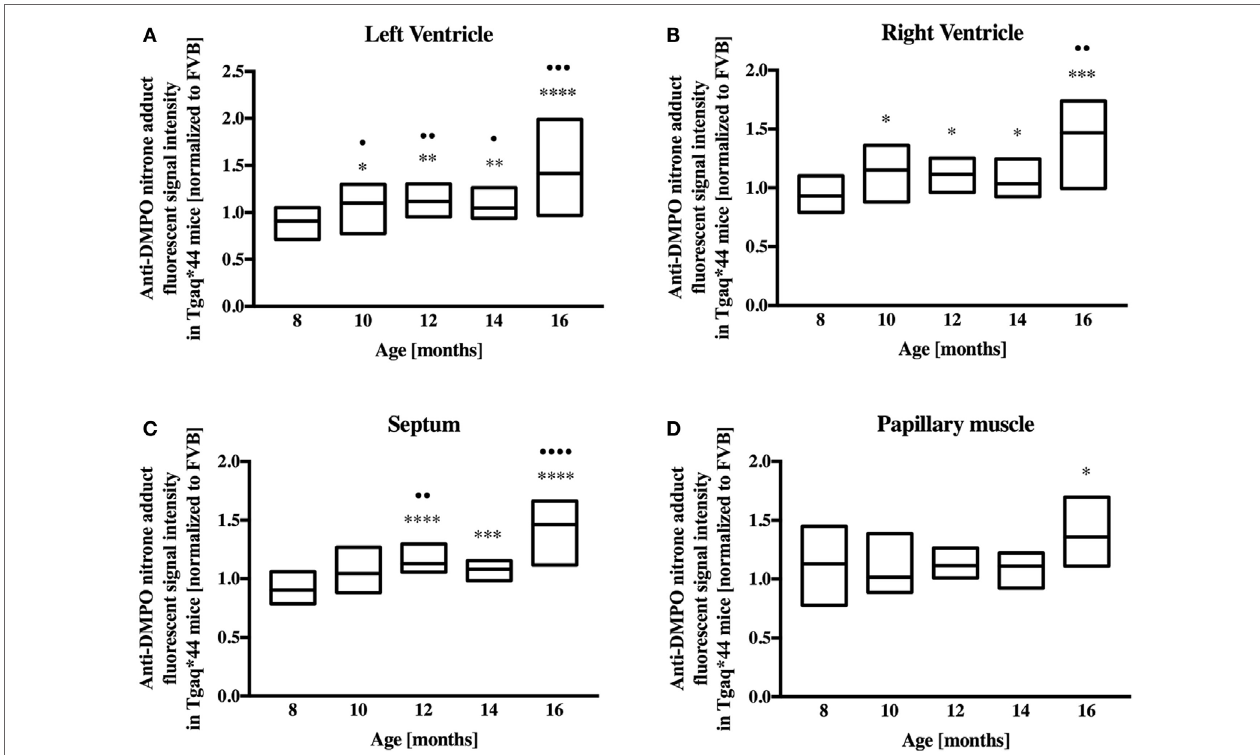
FigUre 3 | Regional oxidative modifications analyzed using immunohistochemical detection of DMPO nitrone adducts in hearts of Tg α q*44 normalized to aged-matched FVB mice. Quantification of oxidative modifications in the (a) left and (B) right ventricles, (c) septum, and (D) papillary muscle of the myocardium showed inhomogeneous distribution of oxidative modifications in the analyzed regions. Results presented as median ± IQR. Statistical significance of changes compared with the 8-month-old group for the left ventricle, right ventricle, and septum were assessed using Kruskal–Wallis ANOVA with post hoc Dunn’s test ( n = 24–30 fields per group), while data for the papillary muscle were analyzed by one-way ANOVA with post hoc LSD test ( n = 8–12 images per group); • P < 0.05, ••